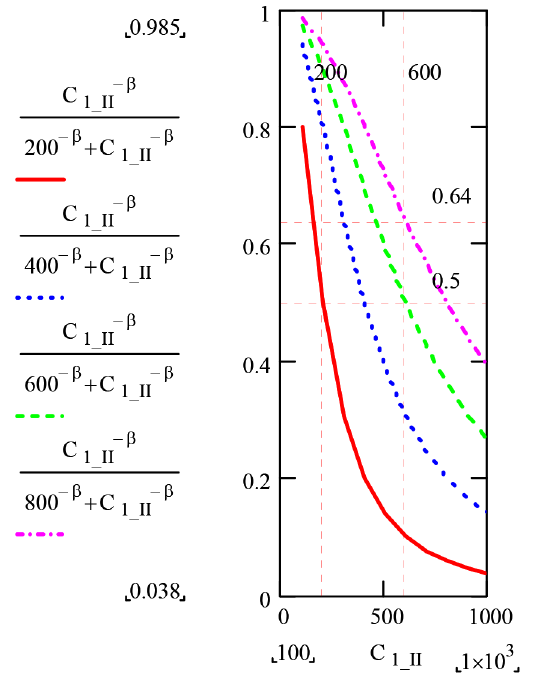
Fig. 2. Changes of the first expert’s preferences for the first maintenance